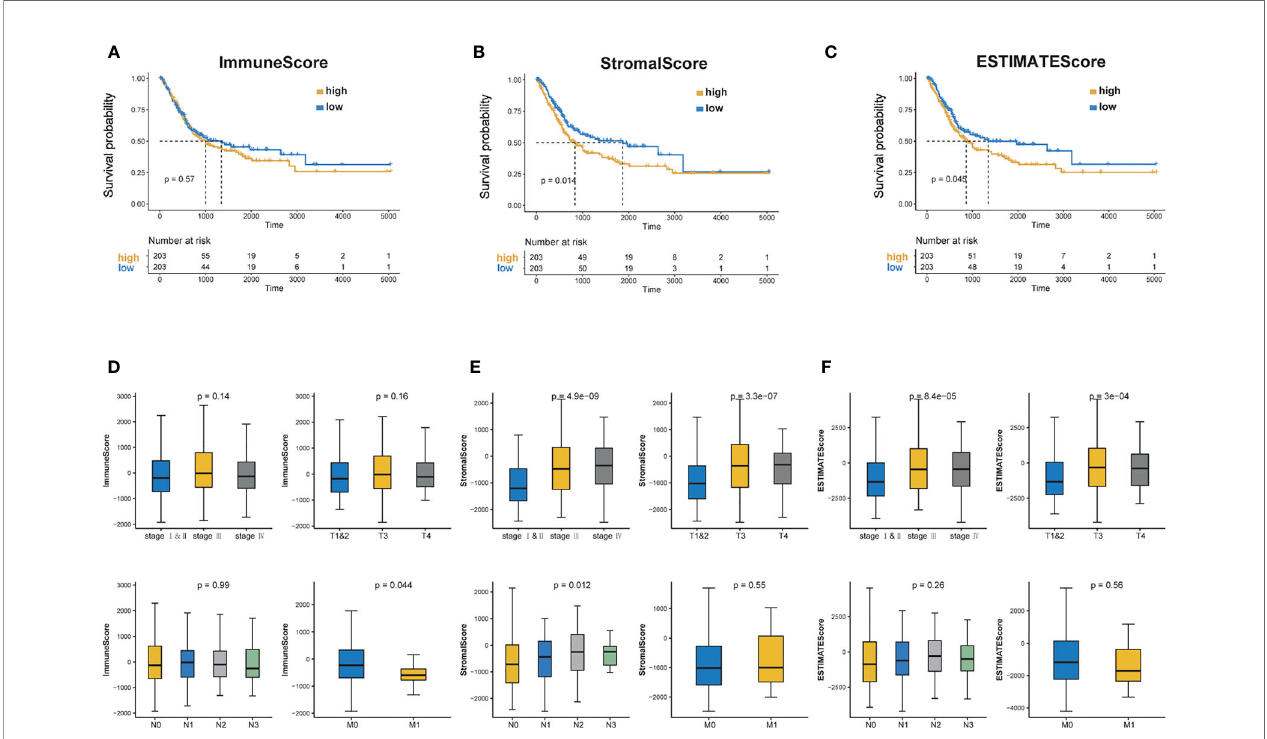
FIGURE 1 | Correlation of scores with the survival of BC patients and clinicopathological staging characteristics. (A – C) Kaplan – Meier survival analysis for BC patients of high and low score in ImmuneScore, StromalScore and ESTIMATEScore. p = 0.57, 0.014 and 0.045 by Log Rank test. (D) Distribution of ImmuneScore in stage, T classi fi cation, N classi fi cation and M classi fi cation. The p = 0.14, 0.16, 0.99 and 0.044, respectively. (E) Distribution of StromalScore in stage, T classi fi cation, N classi fi cation and M classi fi cation. The p = 4.9e − 09, 3.3e − 07, 0.012, 0.55, respectively. (F) Distribution of ESTIMATEScore in stage, T classi fi cation, N classi fi cation and M classi fi cation. The p = 8.4e − 05, 23e − 04, 0.26 and 0.56,